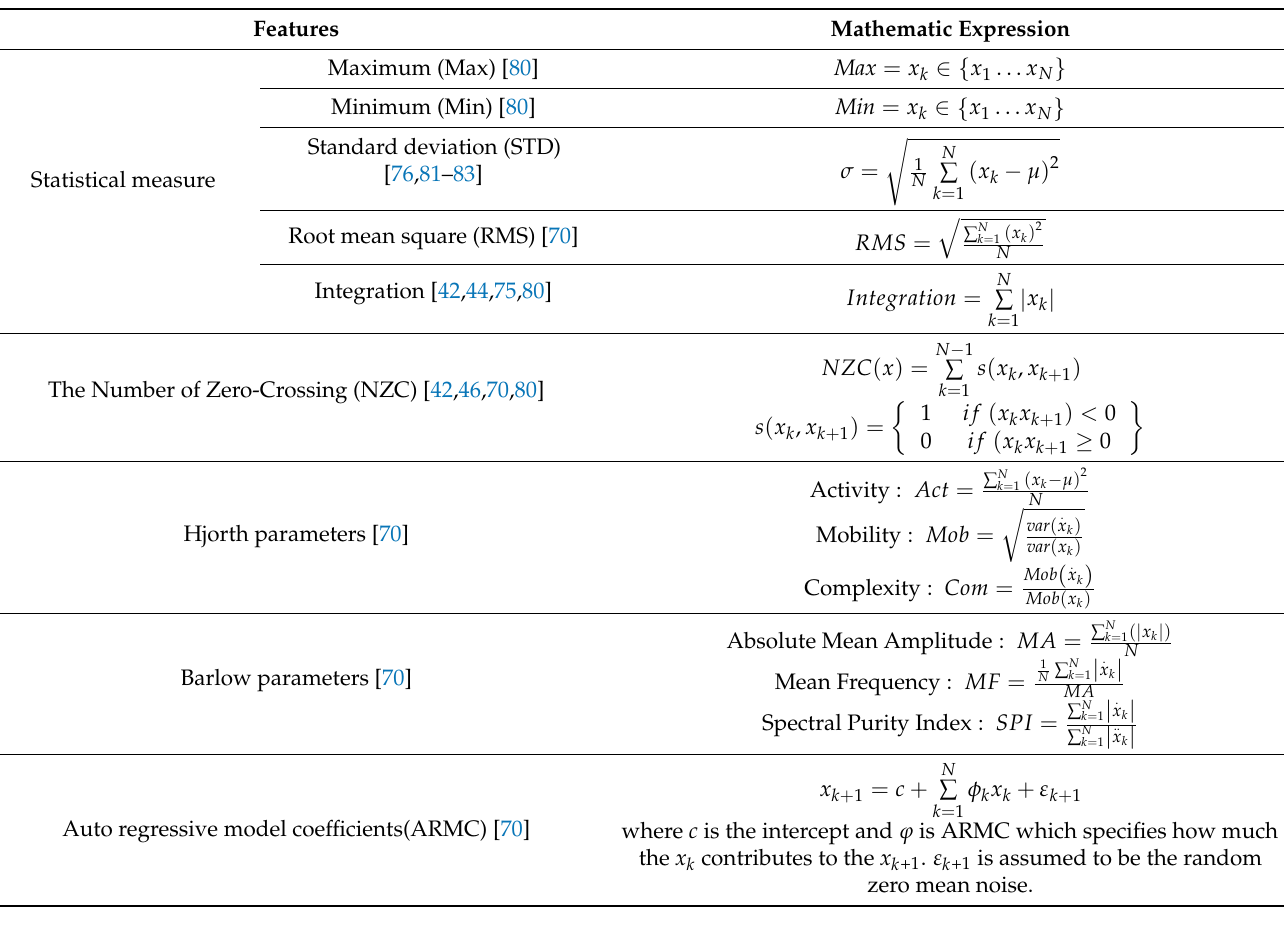
Table 2. The summary of the time domain features used in EEG-based